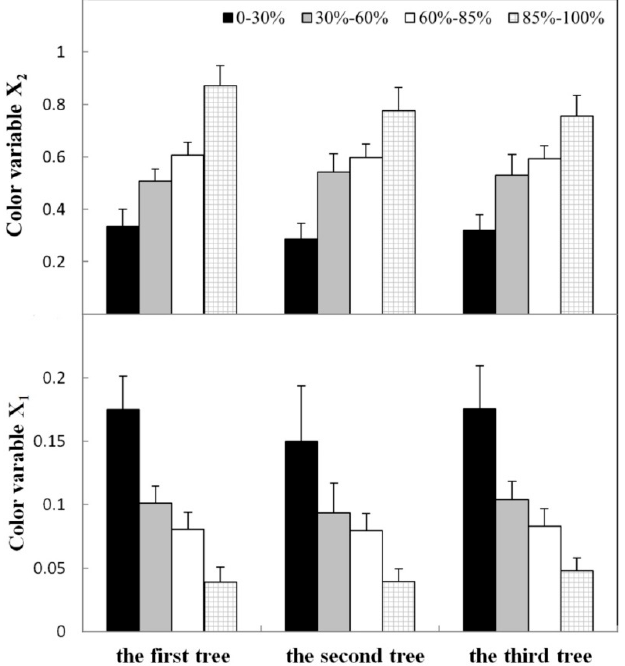
Figure 9. Color distribution in different RLI areas.